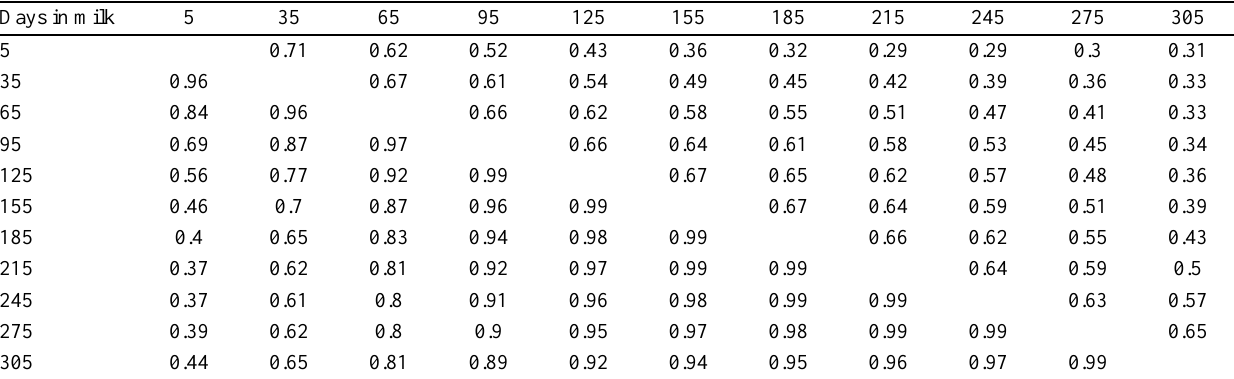
Table 3. Genetic (below the diagonal) and phenotypic correlations (above the diagonal) between selected days in milk for Holstein Friesian from the random regression test-day model Days in milk